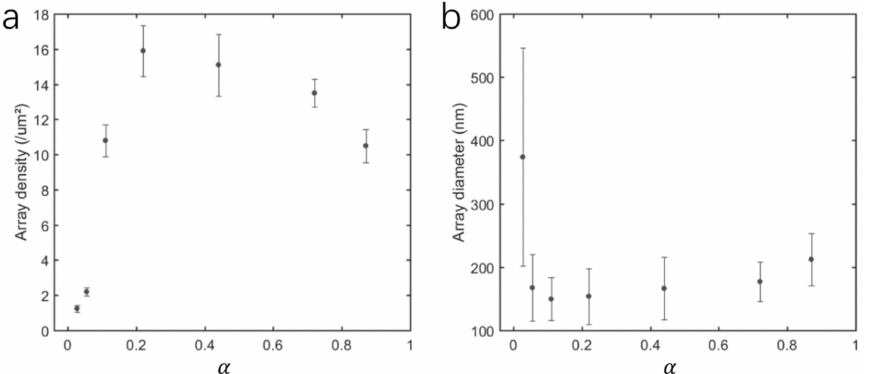
Figure 4. Variation of nanoarrays morphology parameters with ZnAC/PVA volume ratio α . ( a ) and ( b ) are statistics of the number density and diameter of nanorods,